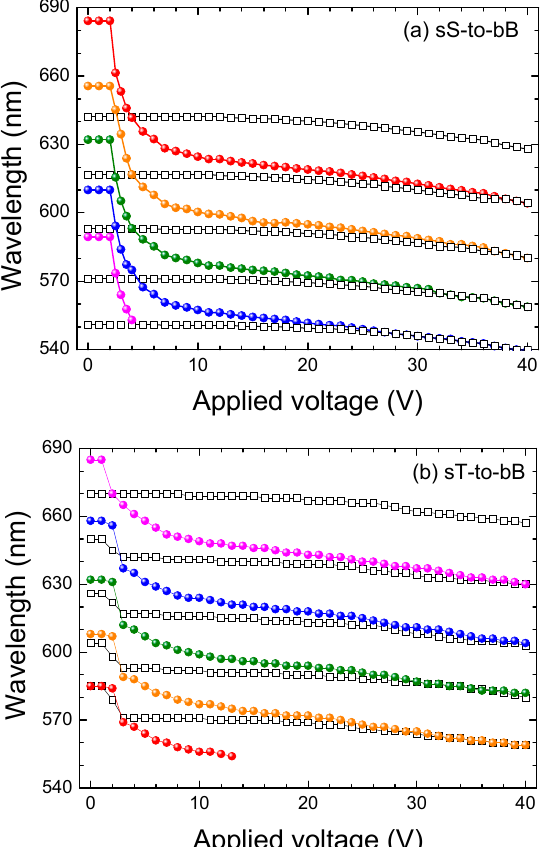
Figure 5. Voltage-dependent wavelengths of some specific defect modes in the PC/CD-DFLC cell through voltage-induced: ( a ) sS-to-bB textural transition; and ( b ) sT-to-bB textural transition . The solid and hollow symbols represent the extraordinary (E) and ordinary (O) components of defect modes, respectively.